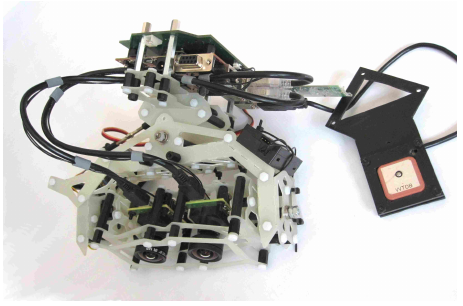
Figure 2: Close-up of constructed camera system with: (bottom) two board-level cameras in pan-tilt unit; (right) GNSS receiver mounted on top of the UAV during flight; (top) single-board-computer interfacing the cameras and the GNSS receiver.